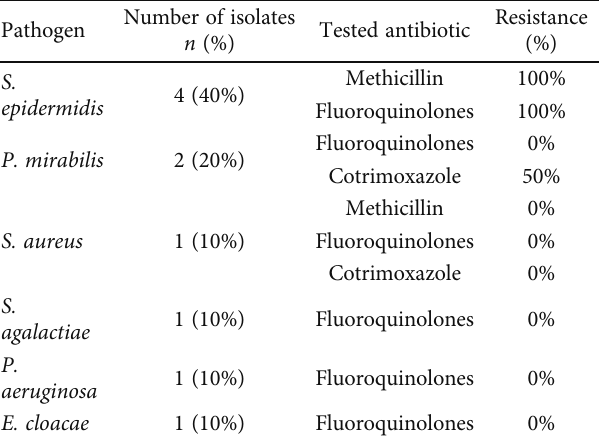
Table 3: Isolated pathogens and their resistance pattern.